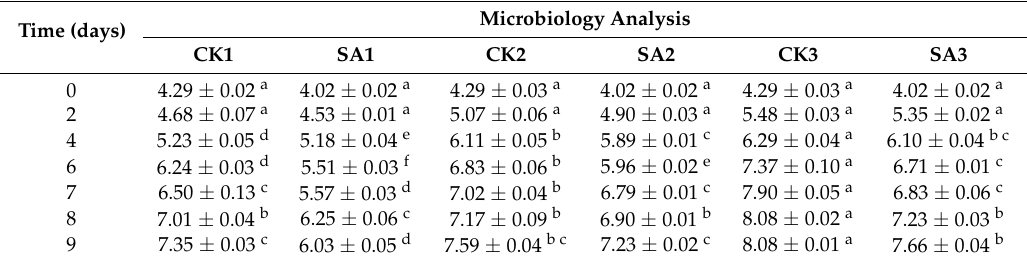
Figure 2. Effect of cell-free supernatant (CFS) from Aeromonas sobria on the growth of Shewanella putrefaciens in Pacific white shrimp ( Litopenaeus vannamei ) during different cold chain logistics. Table 1. Effect of CFS from A. sobria on the growth of S.putrefaciens in Pacific white shrimp ( L. vannamei ) during different cold chain logistics by F test.